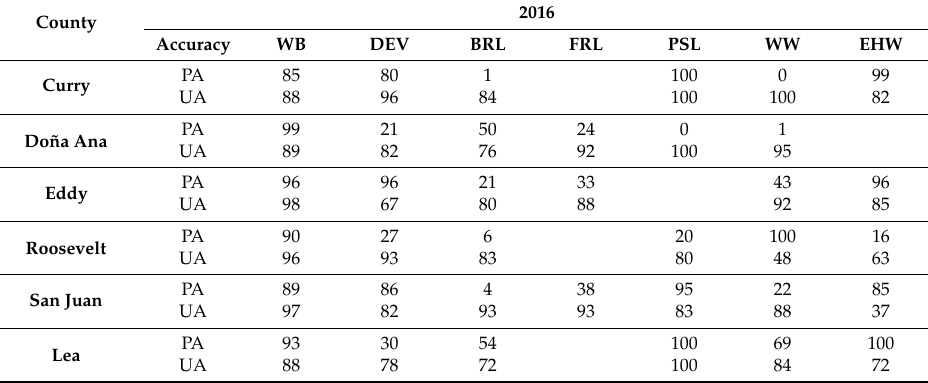
The description of the di ff erent columns and row is same as in Table A1. Table A6. User’s and producer’s accuracy for the rest of the LULC classes for the NLCD map of 2016. County